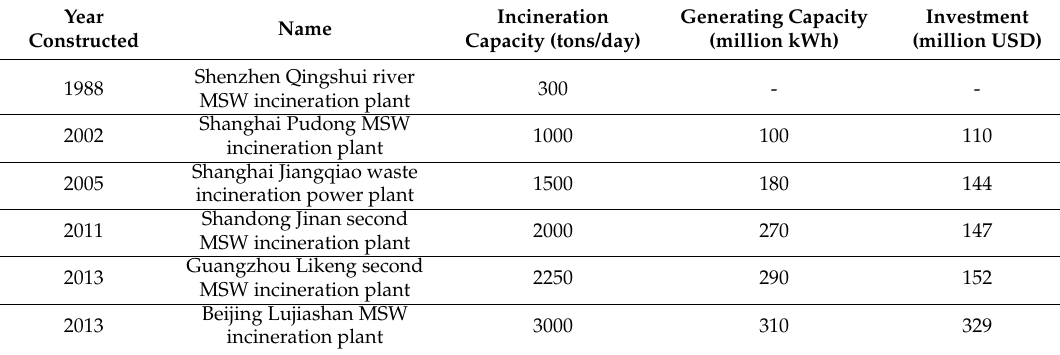
Table 2. Significant MSW incineration power plants in China